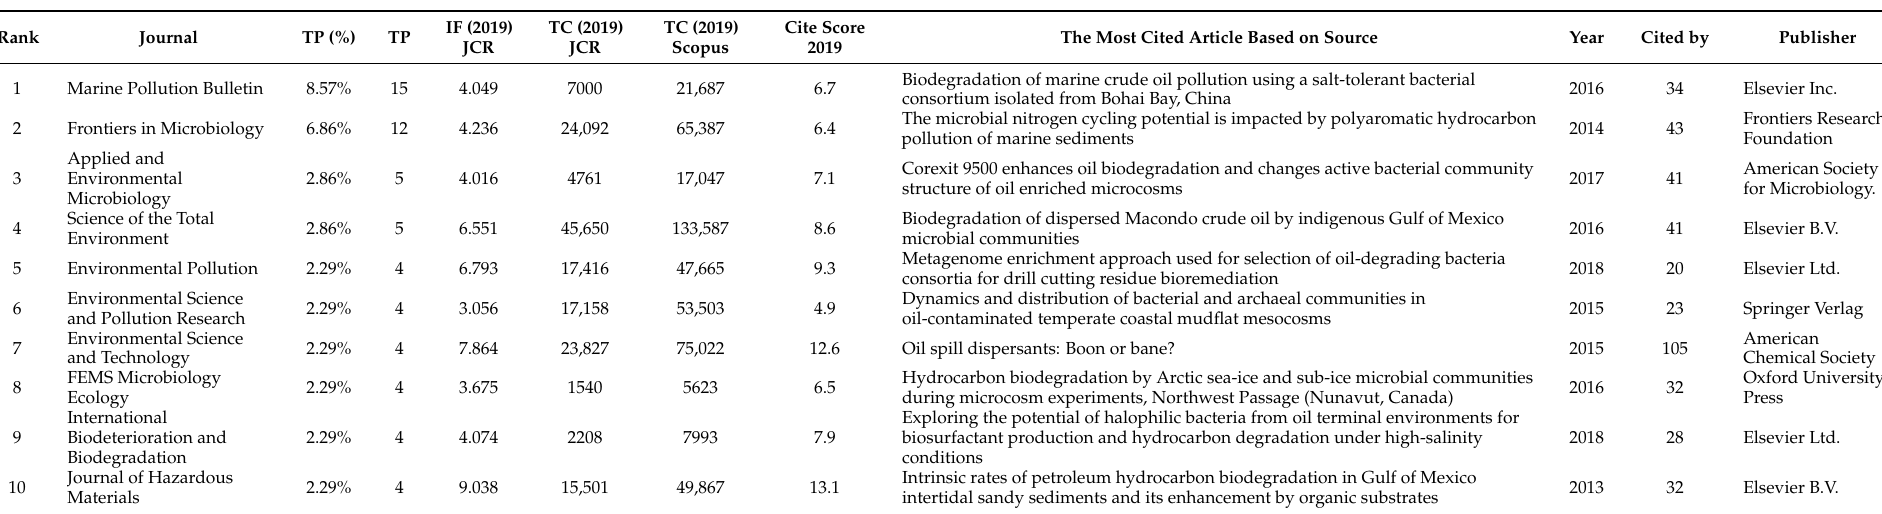
Table 2. Top ten most productive journals on degradation of hydrocarbons by Arctic microbial community research with their most cited